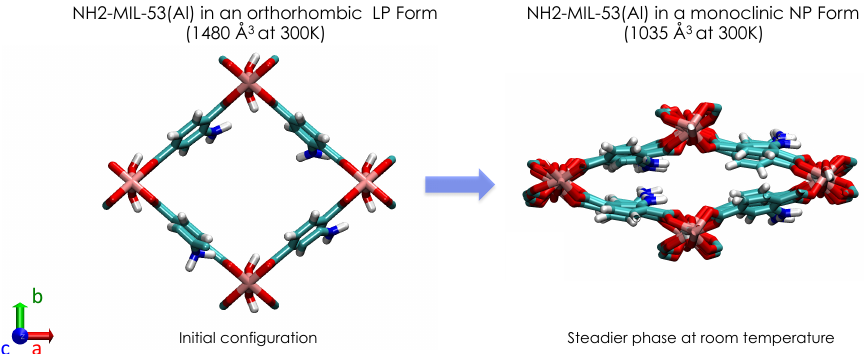
Figure 1. Illustration of the initial Narrow Pore (NP) and Large Pore (LP) forms of the NH 2 -MIL-53(Al) metal organic